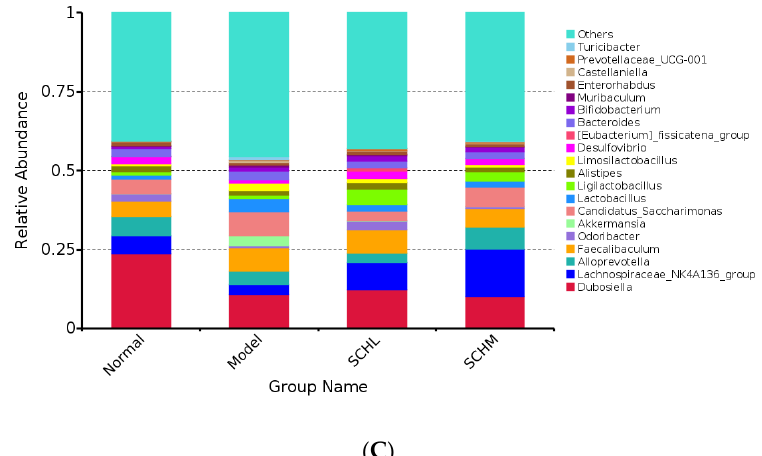
Figure 6. Effect of SCH on gut microbiota in immunosuppressed mice. NMDS analysis of the gut microbiota in each group ( A ). The relative abundance of gut microbiota of mice in each group at the phylum ( B ) and genus ( C ) levels. The results are presented as the means ± SD (n ≥ 4).